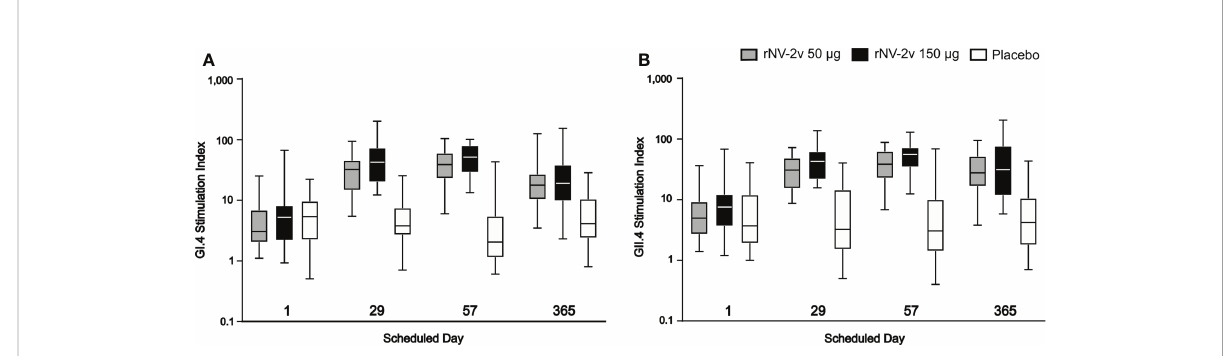
FIGURE 7 Cellular immune response. Cellular immune response measured as GI.4 and GII.4 VLP-speci fi c lymphoproliferative responses by scheduled time for each study group. GI.4 (A) and GII.4 (B) VLP-speci fi c responses for rNV-2v 50µg (grey), 150 µg (black) and placebo (white) are expressed as stimulation indices and shown as boxplots. The horizontal line represents the median, the bottom and top of the box represent 25 th and 75 th percentiles of the values, respectively, and the upper and lower error bar represent 5 th and 95 th percentile of the values, respectively. VLP, virus- like